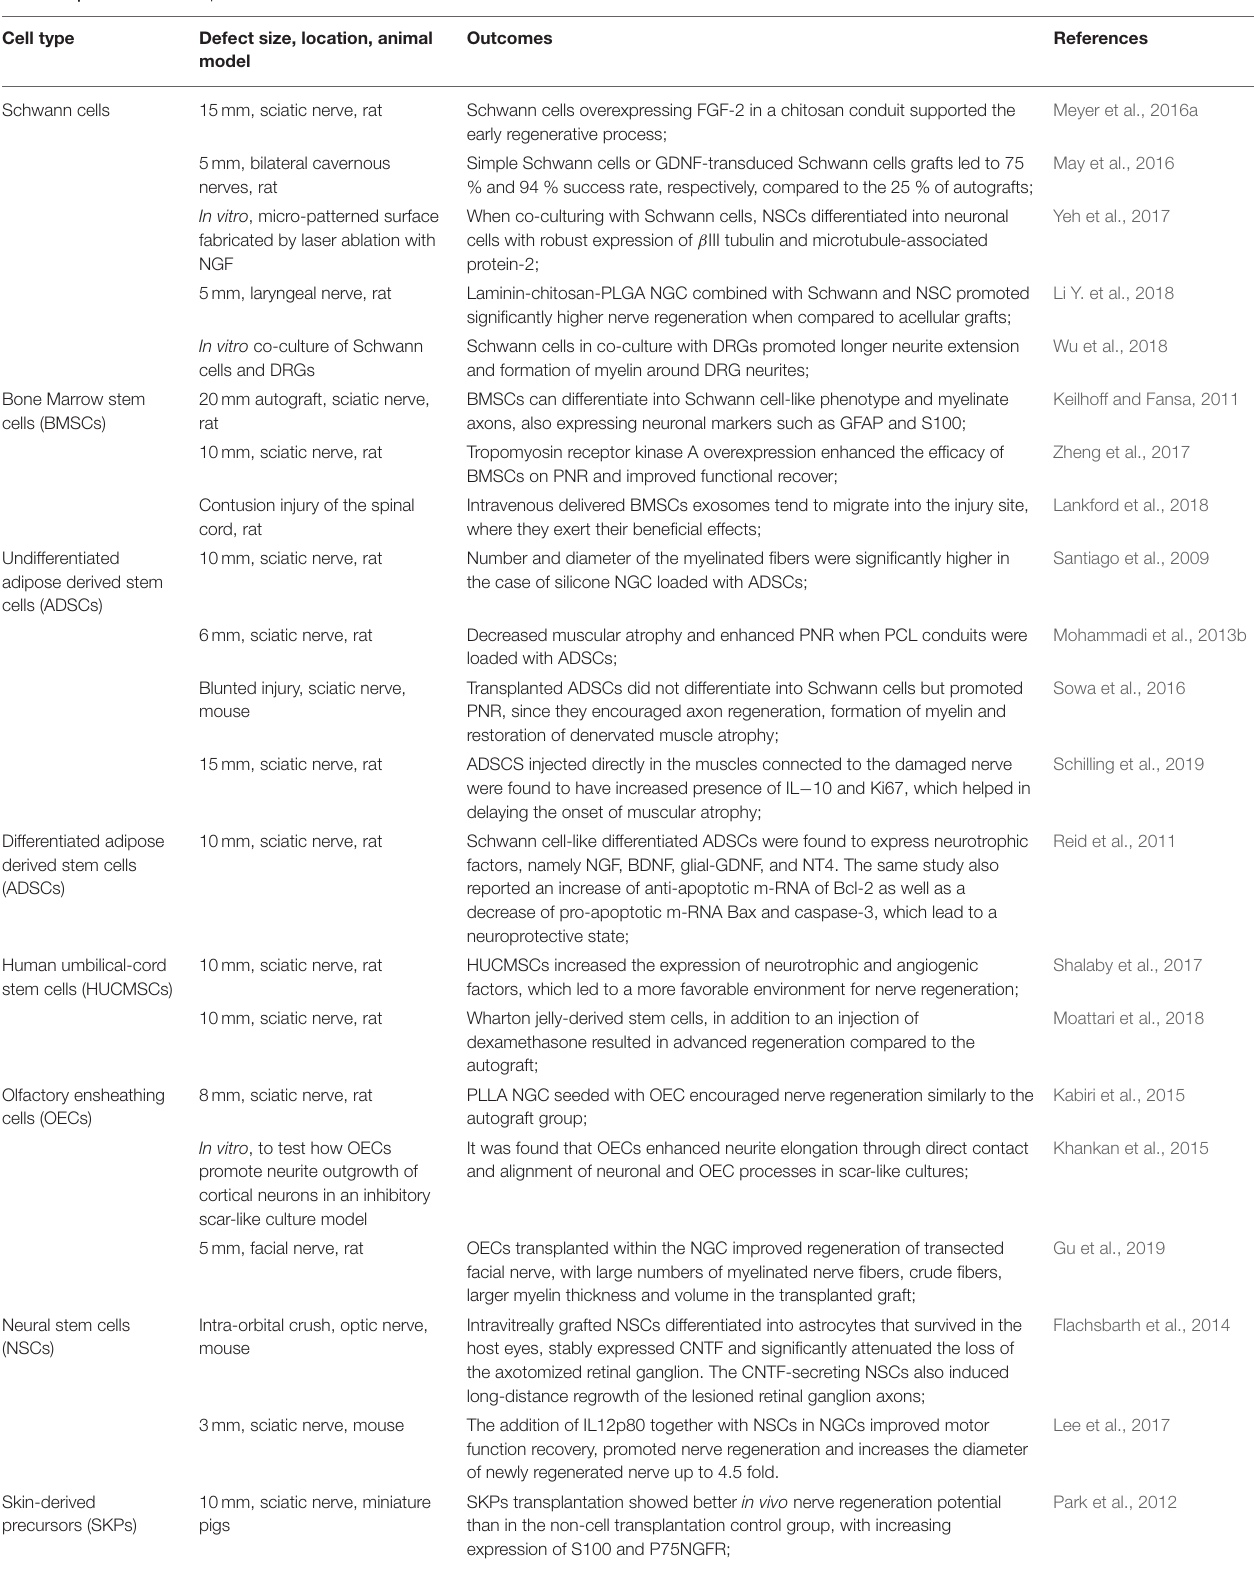
TABLE 2 | Cell-based therapies for